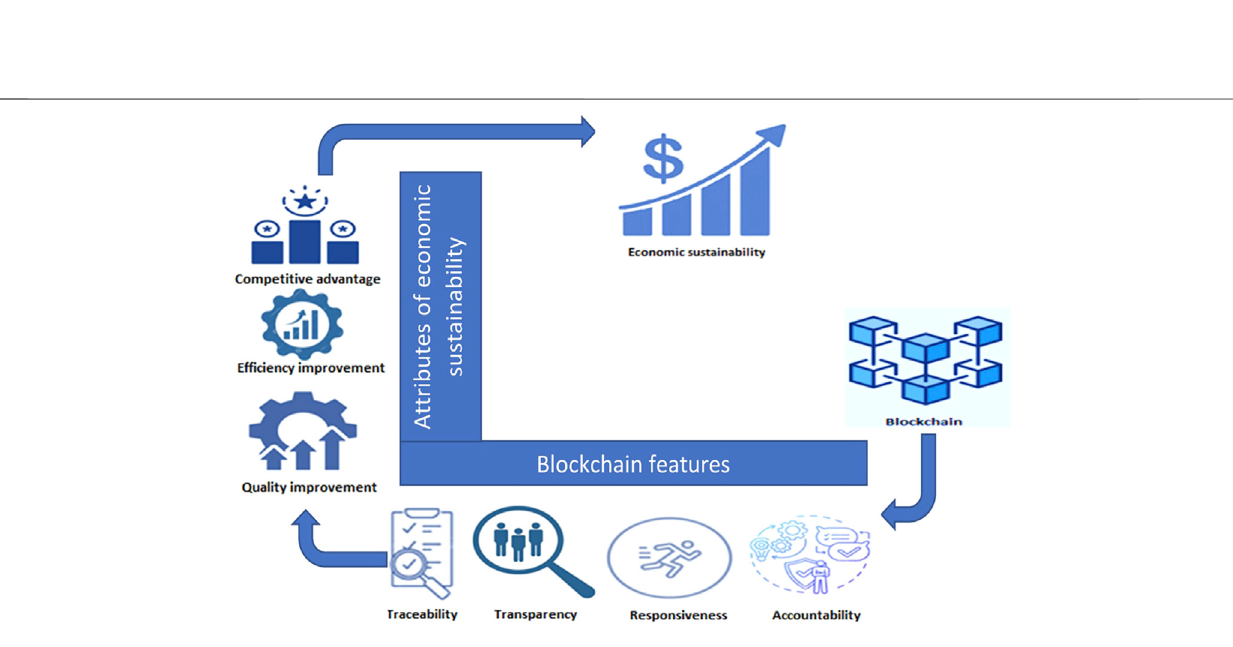
Frontiers in Energy Research | www.frontiersin.org May 2022 | Volume 10 | Article 899632